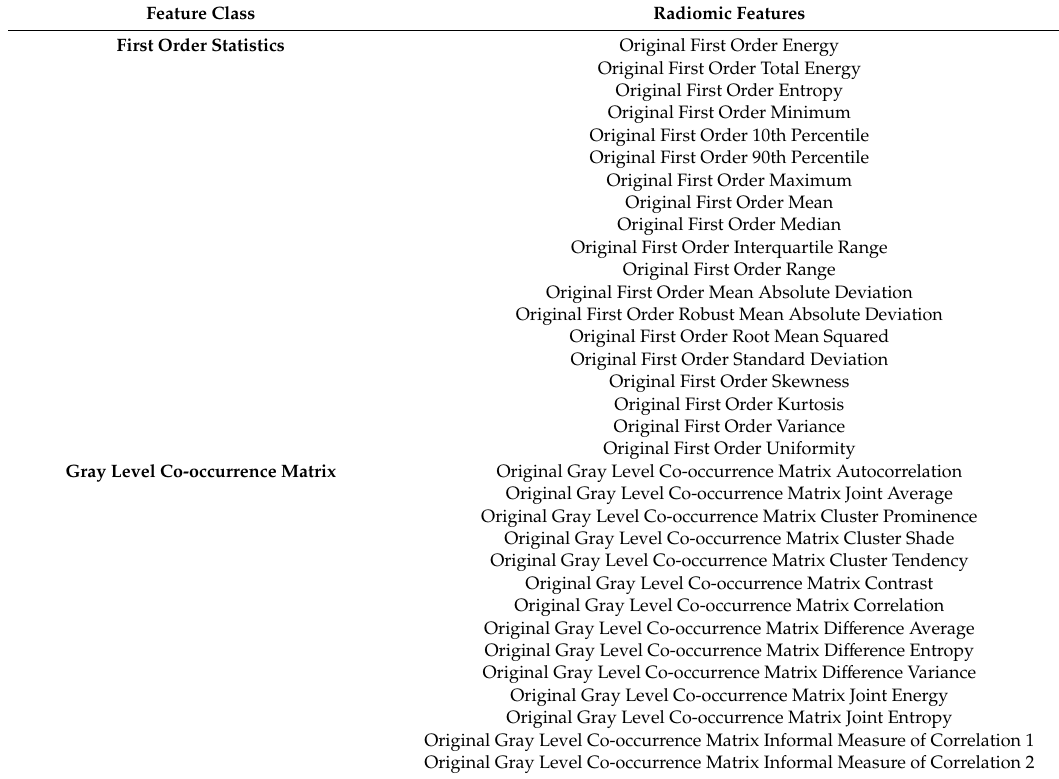
Table A6. All Radiomic Features Listed By Feature